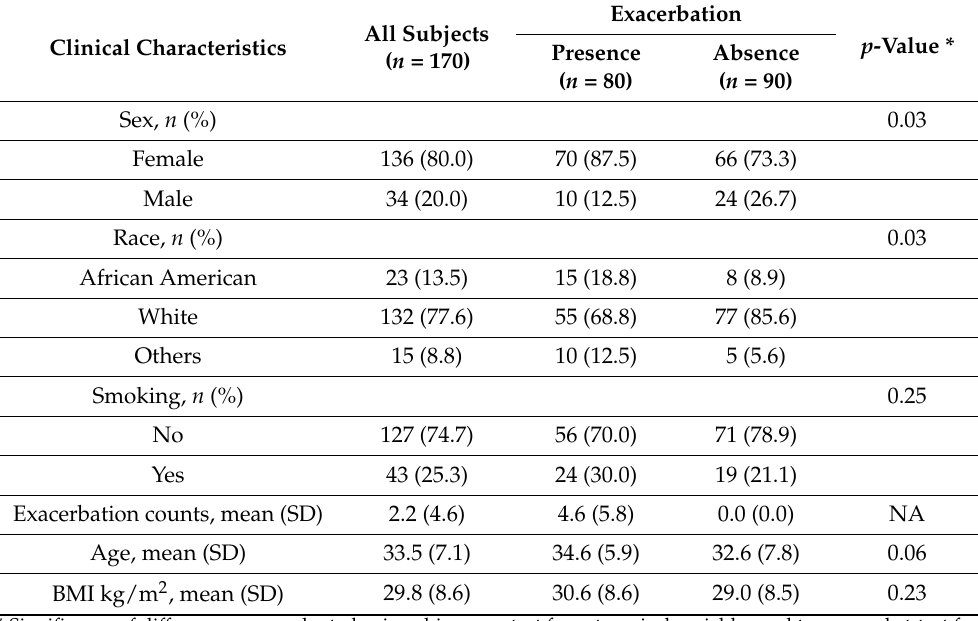
Table 1. Clinical characteristics of the subjects in the MGBB-cohort.